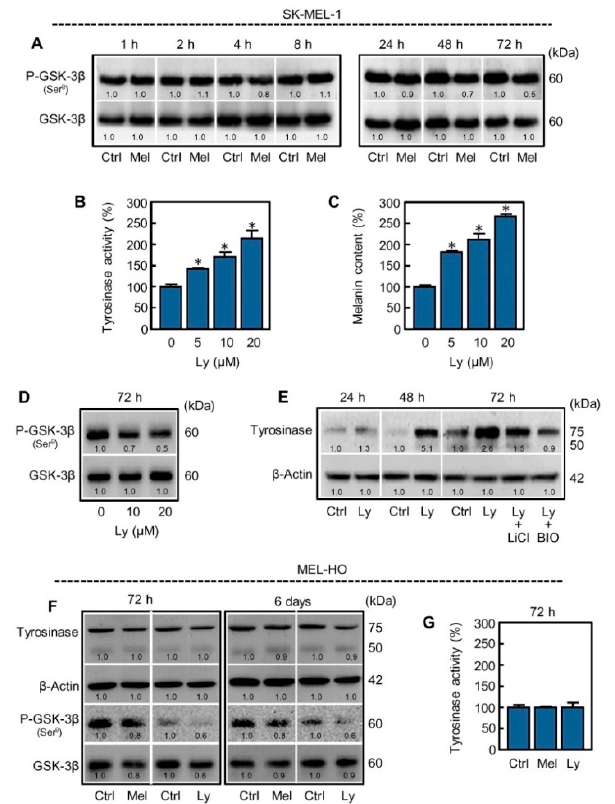
Figure 4. Melatonin reduces the levels of P-GSK-3 β and Ly294002 mimics the effect of melatonin on melanogenesis in SK-MEL-1 cells. ( A ) The cells were incubated in presence of 1 mM melatonin (Mel) for the indicated period of time and P-GSK-3 β was analyzed by immunoblotting. Membranes were stripped and reprobed with a total GSK-3 β antibody as a loading control. ( B,C ) The cells were incubated with the specified concentrations of the PI3K inhibitor Ly294002 (Ly) for 72 h and tyrosinase activity and melanin content evaluated using a microplate reader. ( D ) The cells were treated with the indicated concentrations of Ly294002 (Ly) and P-GSK-3 β was analyzed by immunoblotting. ( E ) The cells were pre-incubated in presence of 20 mM LiCl, or 0.5 µM BIO, for 2 h and then they were treated with 20 µM Ly294002 for the indicated period of time. Expression of tyrosinase was evaluated by immunoblotting and the level of β -actin was also measured as a loading control. ( F ) HO-MEL cells were incubated with 1 mM melatonin or 20 µM Ly294002 (Ly) for the indicated period of time and lysates were analyzed by immunoblotting. ( G ) The cells were treated as above and tyrosinase activity was determined using a microplate reader. * p < 0.05 vs. untreated cells.